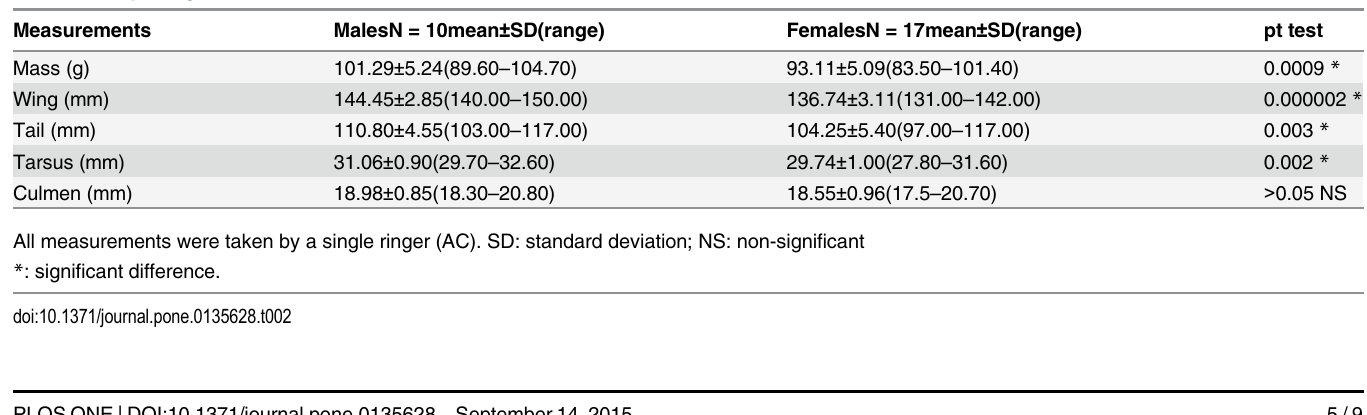
Table 2. Morphological characteristics for males and